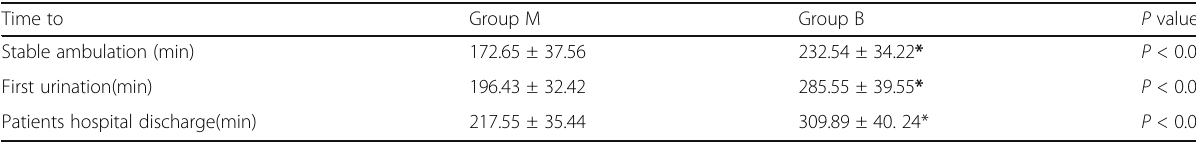
Table 6 Recovery criteria and readiness for discharge (data are presented as mean ± SD) Time to